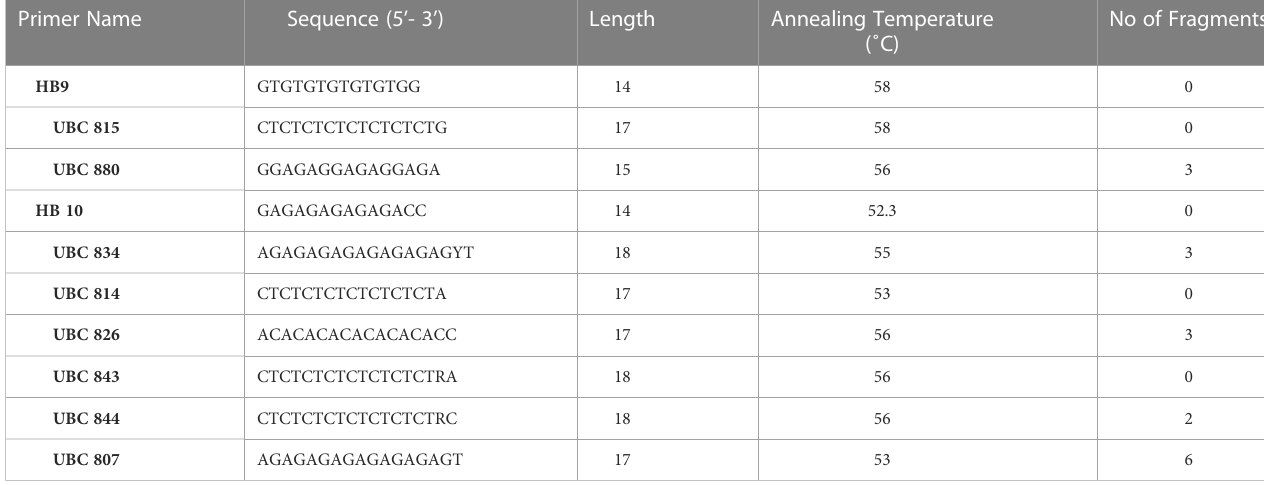
TABLE 5 List of ISSR primers used to con fi rm the genetic fi delity of D. transparens . Primer